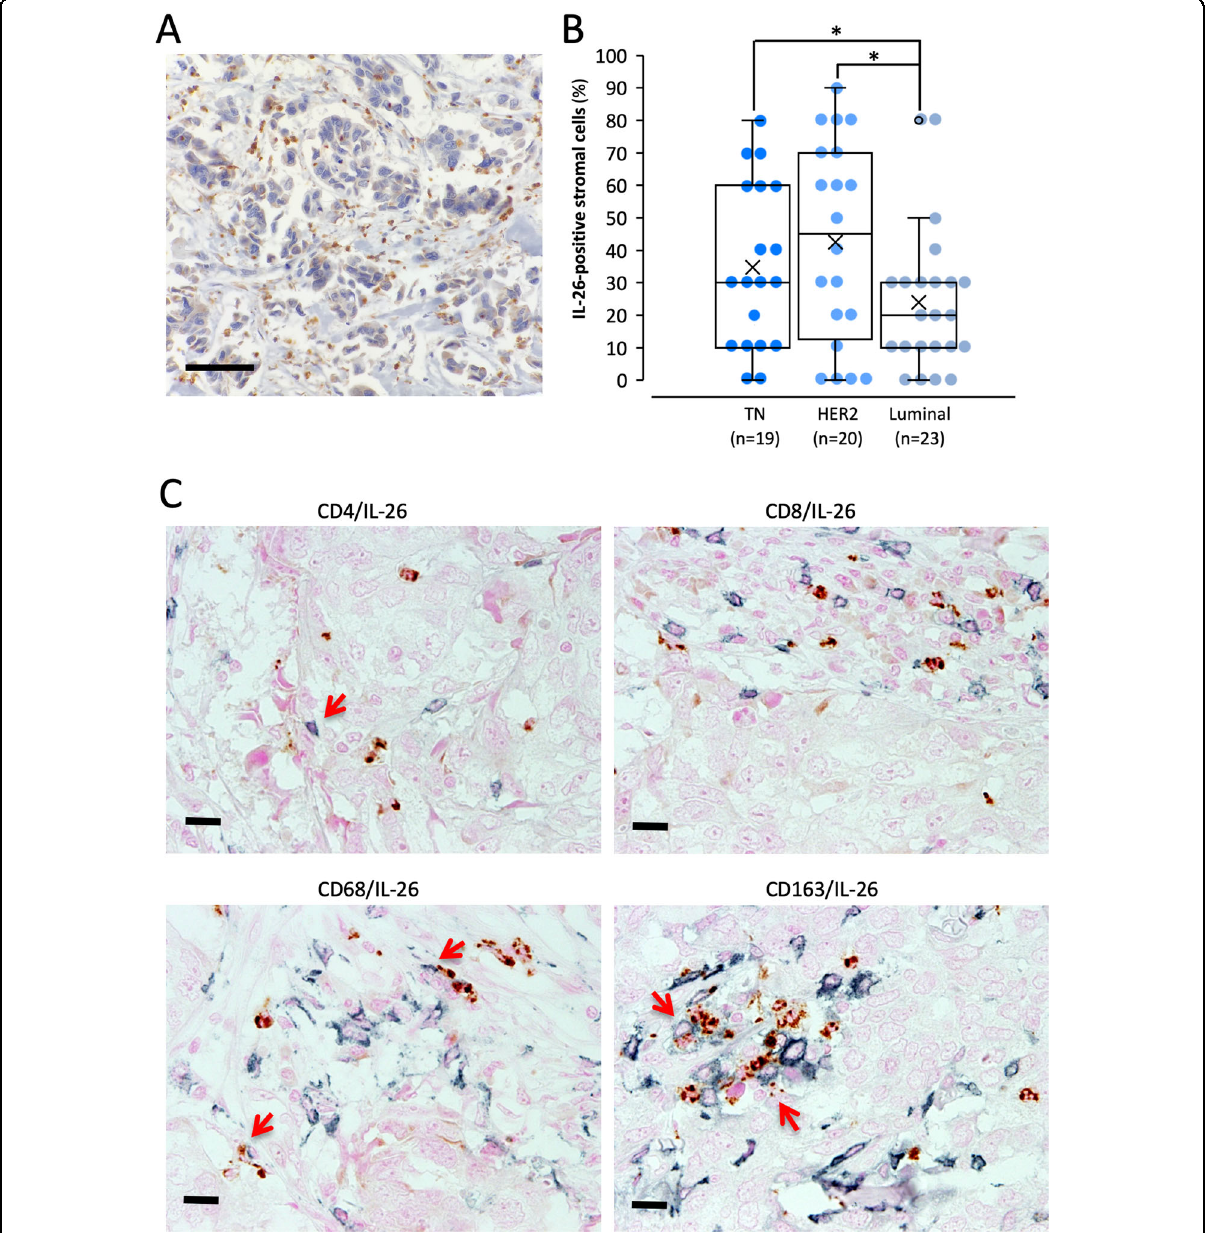
Fig. 1 Immunohistochemistry of breast carcinoma clinical specimens. A TNBC tissue specimens were stained with anti-human IL-26 mAb ( n = 19). All immunohistochemistry specimens were counterstained with hematoxylin. A representative image of the TNBC case with high IL-26 protein expression was shown. Original magni fi cation, ×100. Scale bar, 50 μ m. B Each subtype of breast carcinoma tissue specimen was stained with anti- human IL-26 mAb (TNBC ( n = 19), HER2 ( n = 20), and Luminal ( n = 23)). IL-26 in cytoplasm staining of stromal immune cells was determined semi- quantitatively in 10% increments. The percentage of IL-26-positive stromal immune cells in each subtype of breast carcinoma is shown. * p < 0.05. C TNBC tissue specimens (the same case as shown in A ) were double-stained with IL-26 (brown) plus CD4, CD8, CD68, or CD163 (blue), respectively. All tissue sections were counterstained with hematoxylin. IL-26 was merged with cell surface CD4, CD68, and CD163 (arrows in each panel). Original magni fi cation, ×40. Scale bar, 25 μ